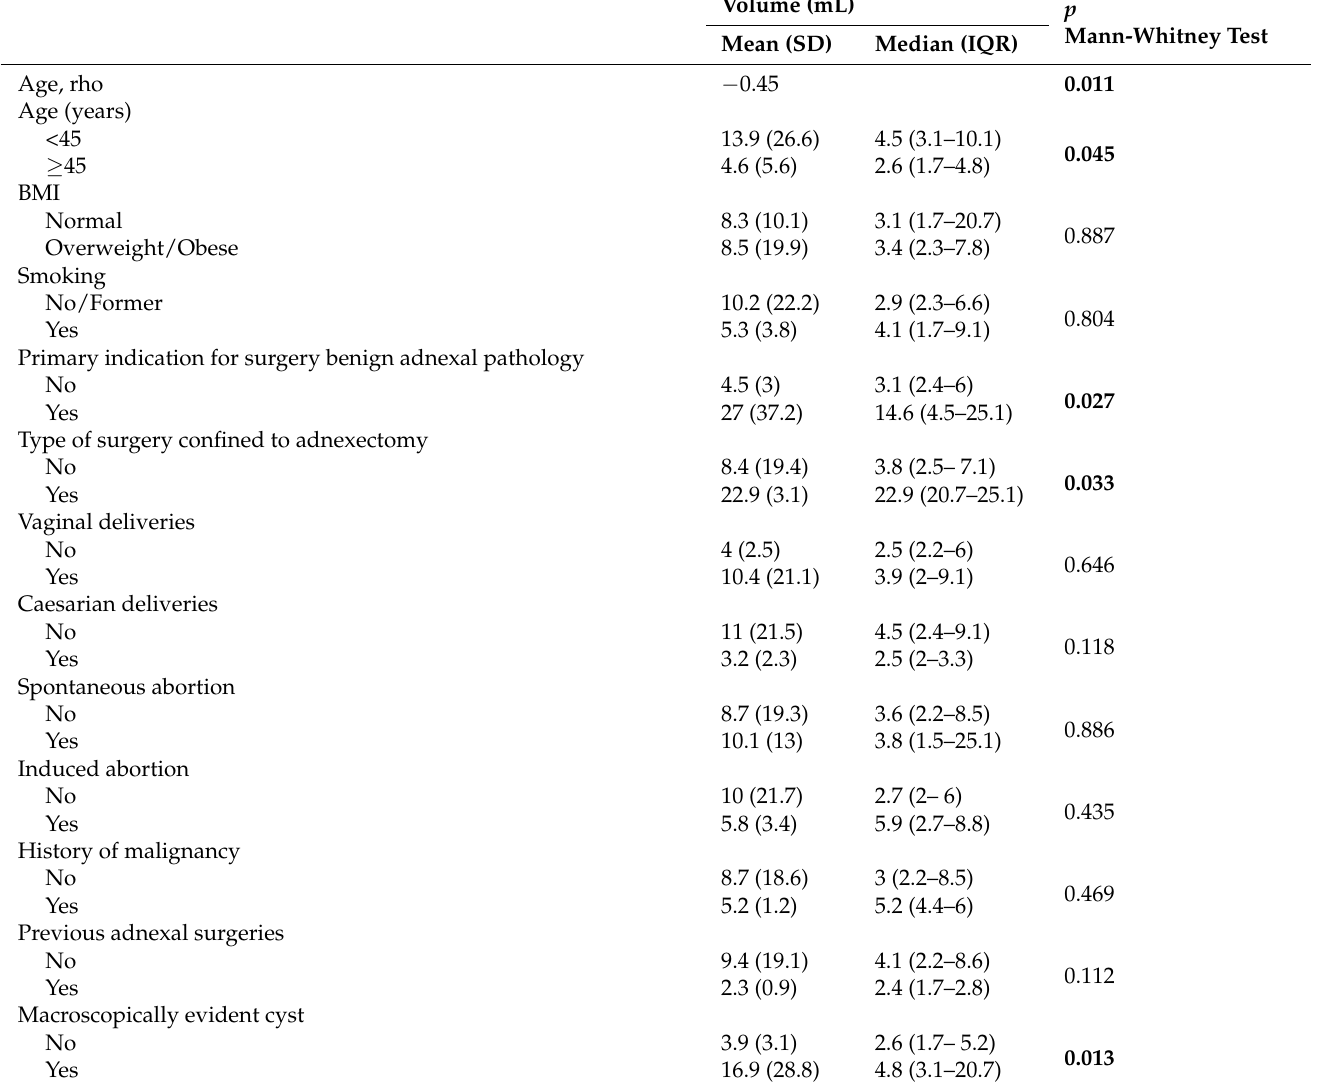
Table 4. Association of volume with patients’ demographic and clinical